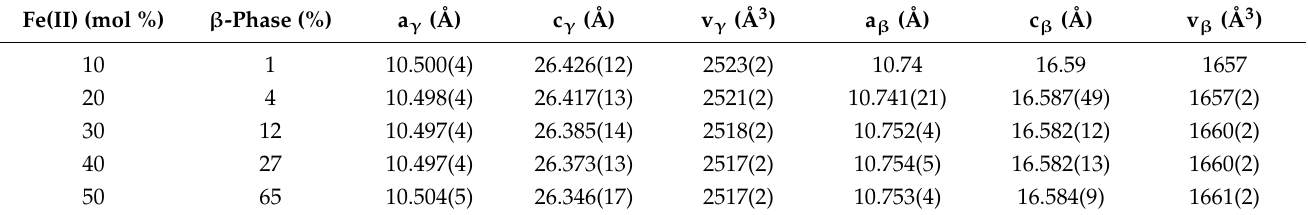
Table 7. Rietveld refinements of co-precipitations of [Fe(bpy) 3 ](PF 6 ) 2 with [Zn(bpy) 3 ](PF 6 ) 2